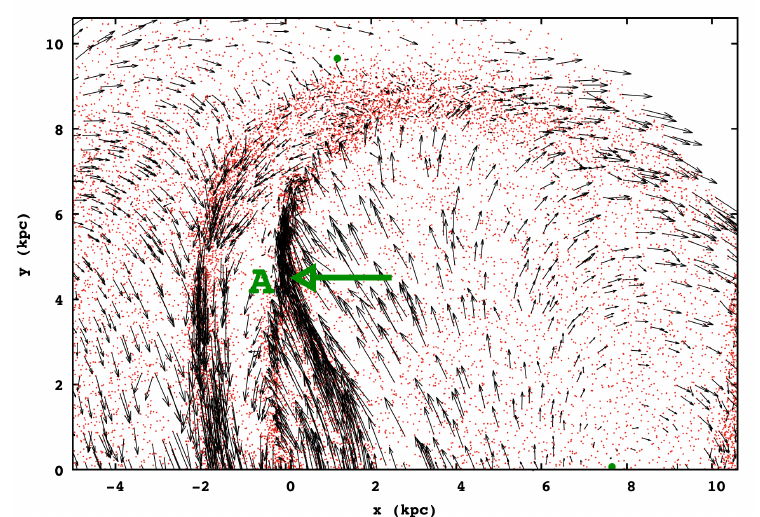
Figure 9. The velocity field of the snapshot of Figure 8 is given by zooming into its ( − 5,11 ) × ( 0,11 ) region. The green arrow indicates point A, where the tail of the lower Γ feature joins the straight-line shocks. The green dot at ( x , y ) = ( 1.21,9.65 ) indicates the location of L 1